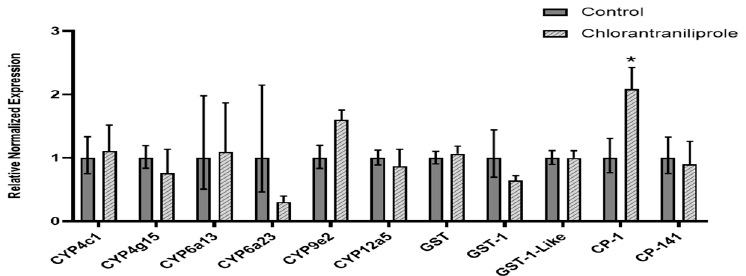
Figure 1. Transcript levels, normalized to RP-18 , in chlorantraniliprole-exposed versus control insects. Data are mean standardized transcript levels (mean ± SEM, n = 4–5). Asterisks represent results significantly different from control samples (* p < 0.05).